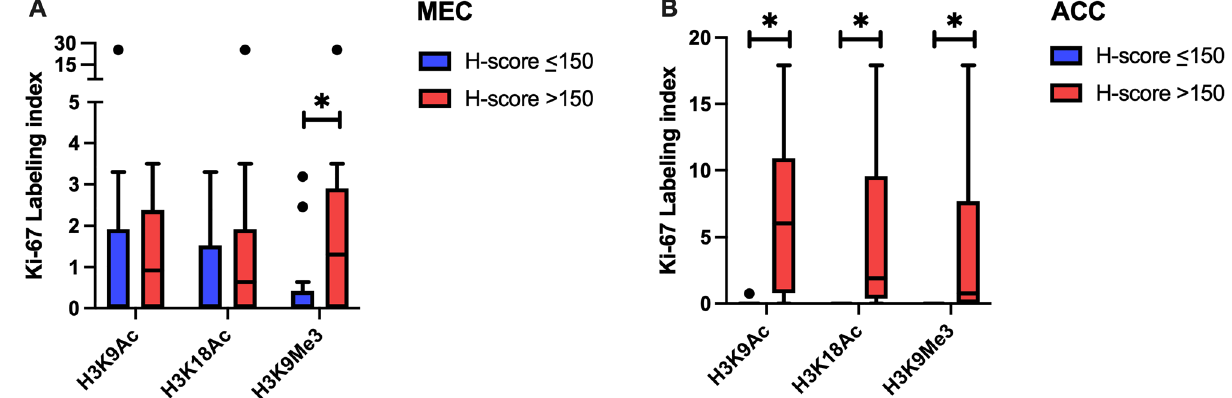
Figure 6. Ki-67 proliferative index of salivary gland malignancies according to the level of histone H3 modification. ( A ) MEC; ( B ) ACC. *Represents statistically significant difference at p <